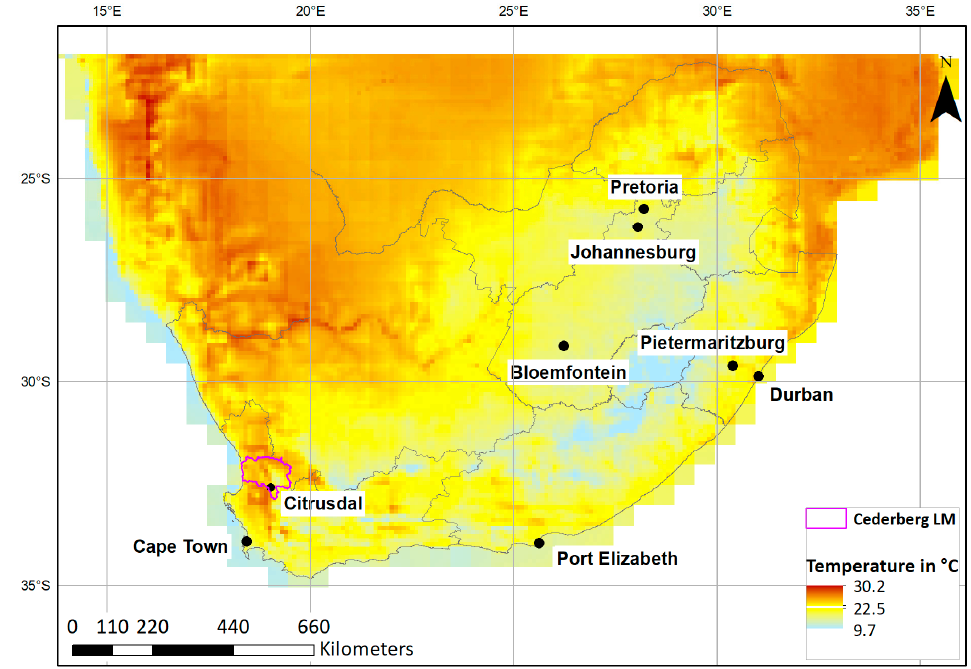
Figure 2. Map of South Africa showing simulated historical (1961–1990) average maximum temperature (°C). Location of Citrusdal in the south-western part of the country is highlighted in the Cederberg Local Municipality (LM) within the Western Cape Province.